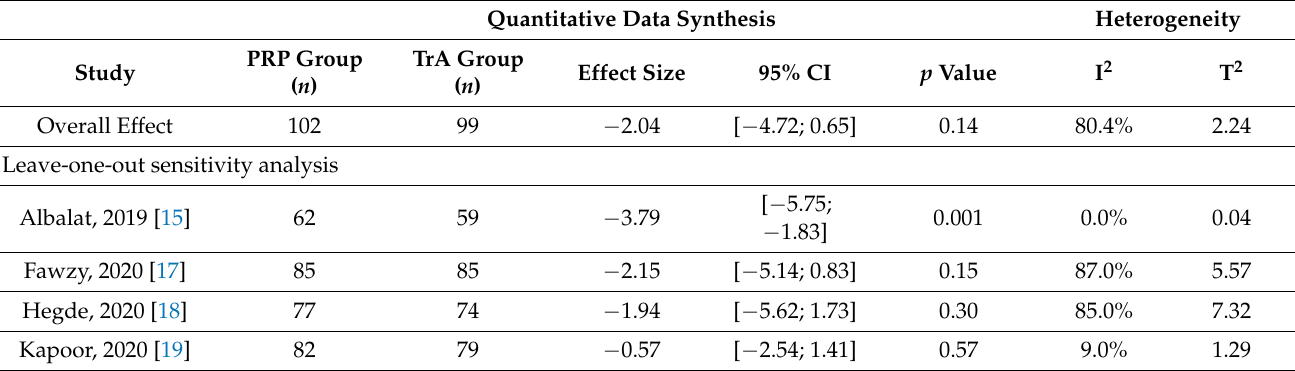
Table 3. Results of leave-one-out